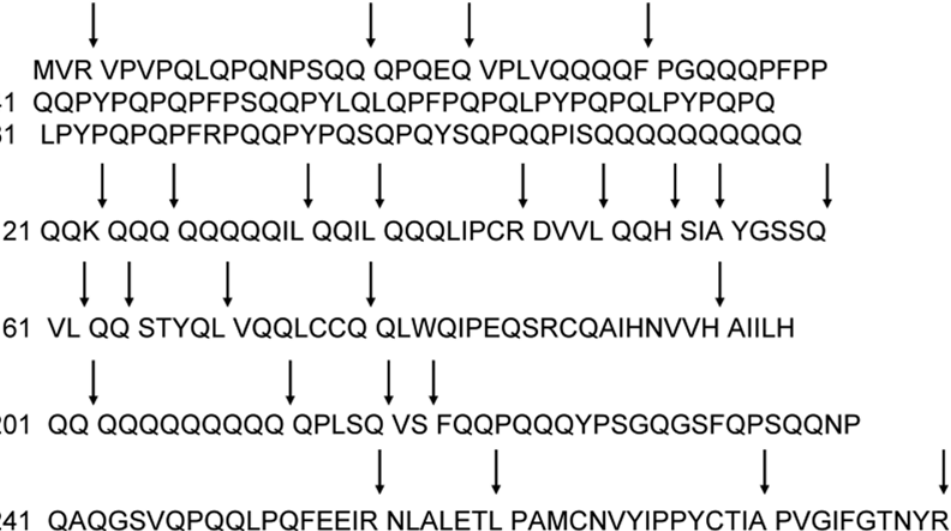
Figure 2. Proteolytic specificity of aspergillopepsin (ASP) for a 2-gliadin. The purified, recombinant protein substrate was incubated for 15 min with food-grade ASP in a 50:1 (w/w) substrate:enzyme ratio at pH 4.5. Cleavage sites were identified by LC/MS/MS, and are indicated by arrows.